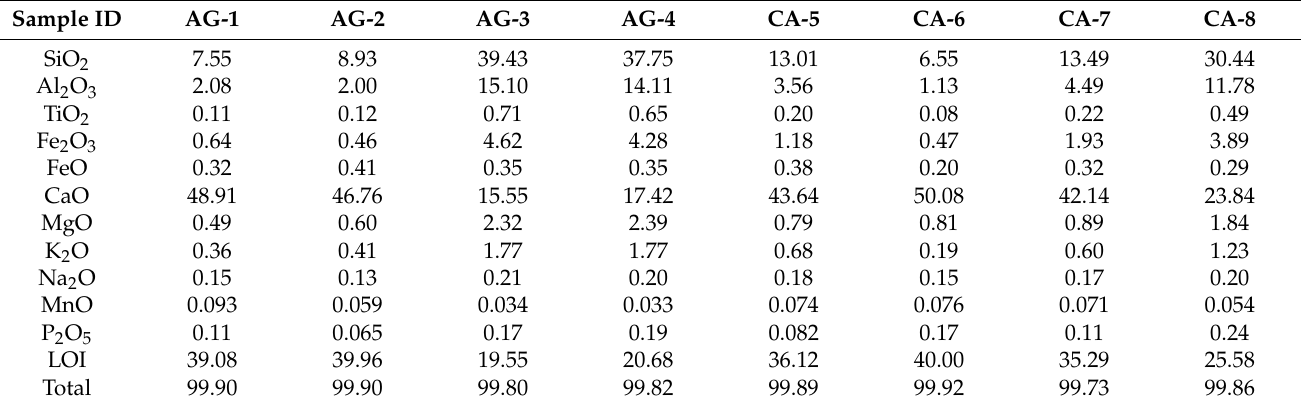
Table 1. Major elements of the samples in oxide